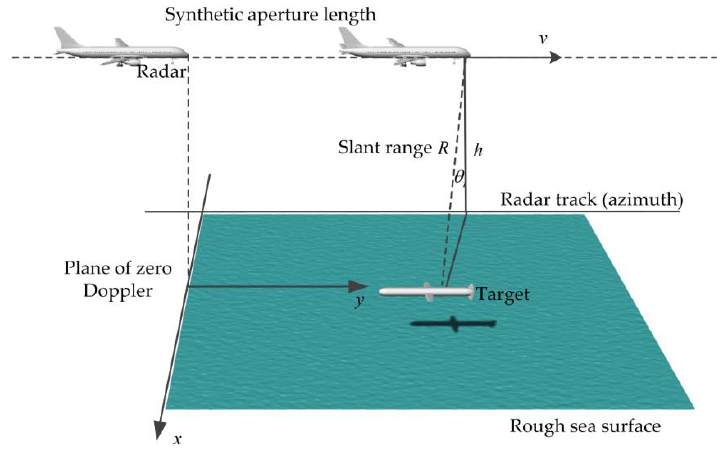
Figure 2. SAR slant range and squint angle geometry.